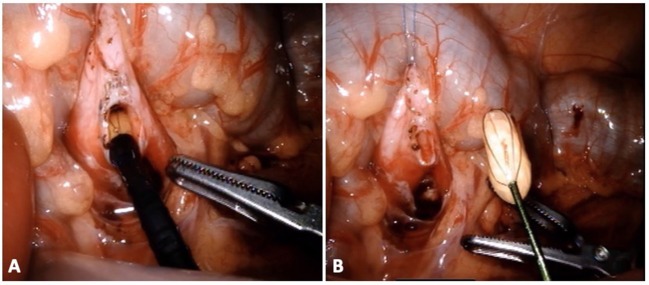
Patient with UPJO and nephrolithiasis undergoing pyeloplasty and concomitant nephrolithotomy. Through the flexible ureteroscope (A), a standard basket device is used for stone extraction (B).